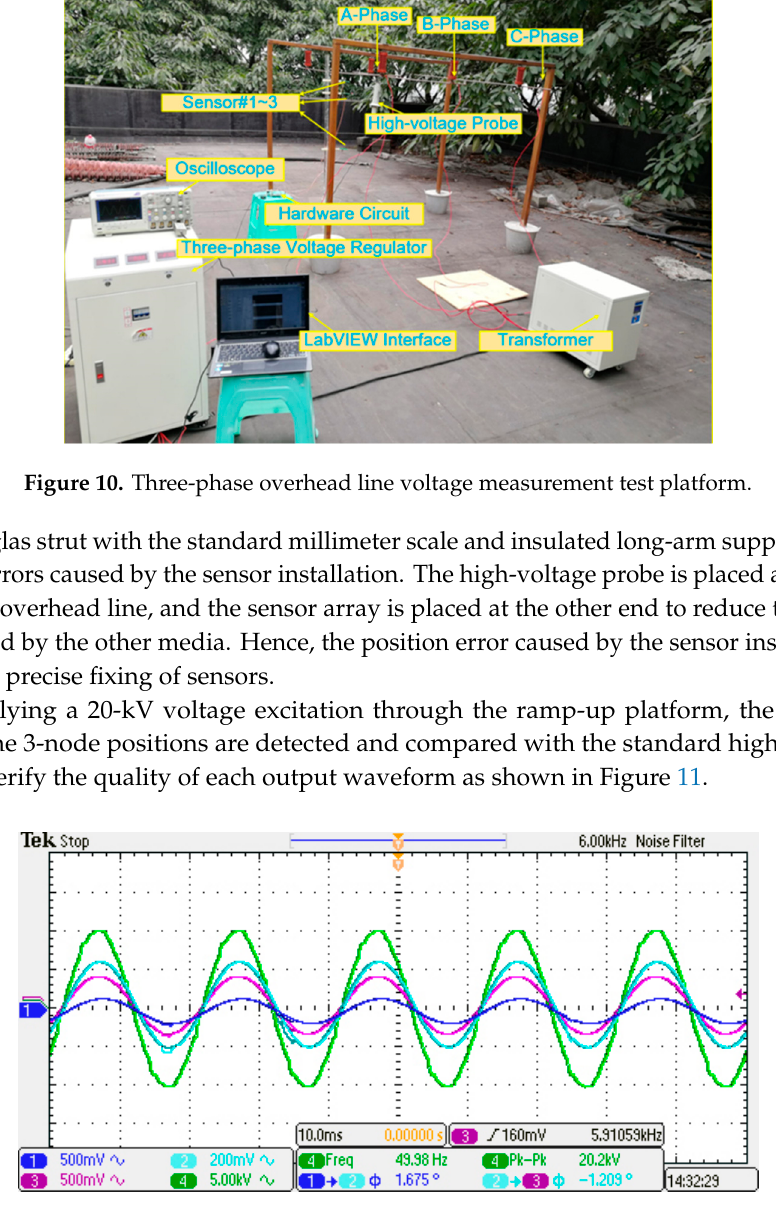
Figure 11. Waveform measured by sensors under the 20-kV voltage excitation.